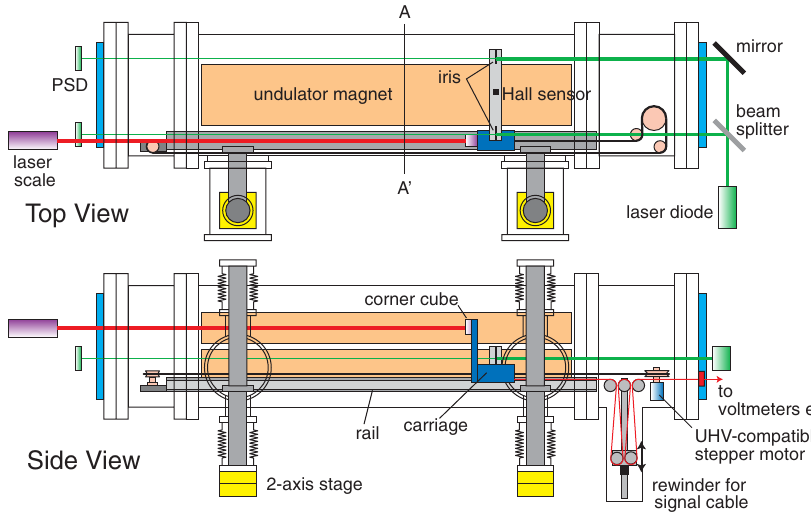
FIG. 3. (Color) Schematic illustration of the measurement